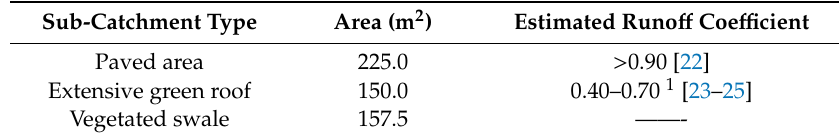
Table 2. Estimated areas of the sub-catchments of the drainage area and runo ff coe ffi cients from the contributing